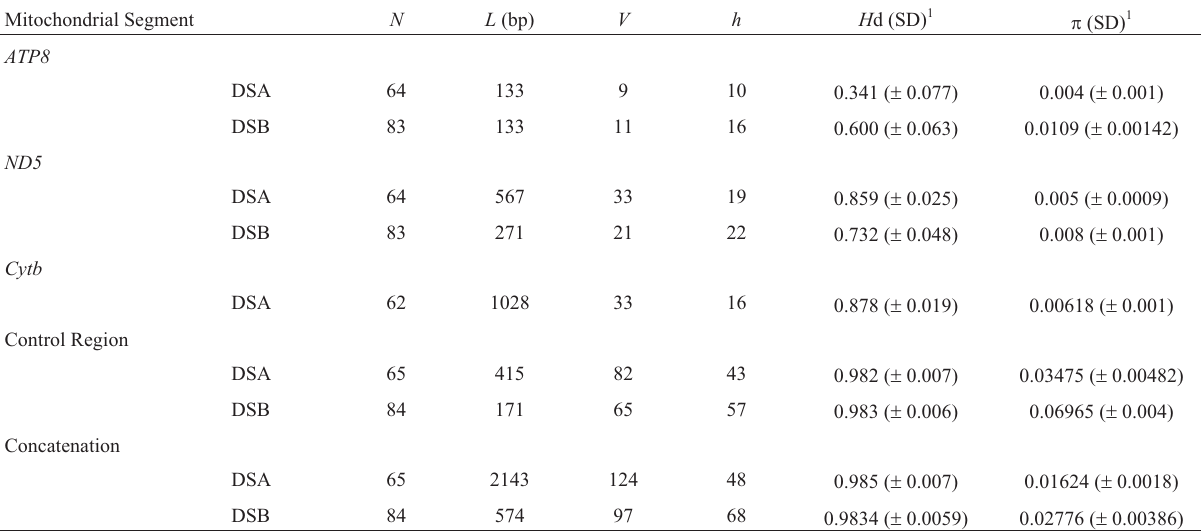
Table 1 - Mitochondrial DNA diversity in Leopardus colocola and L. tigrinus . Diversity estimates are shown for each data set considered (DSA and DSB), and for each segment independently.